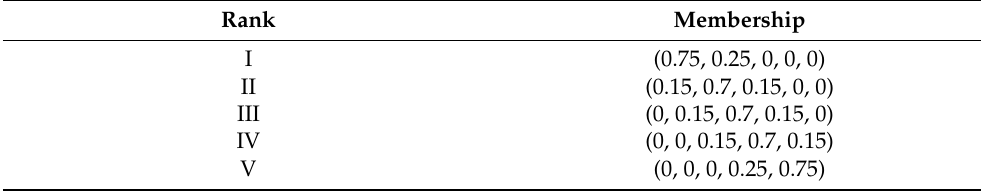
Table 2. Membership degree of qualitative